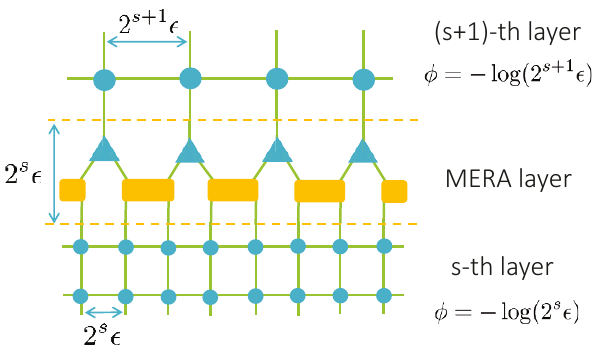
Figure 5 . The tensor network produced when we have a shift of (cid:30) at a speci(cid:12)c layer. This also represents the one step ( s -th) contribution in the process of tensor network renormalization, which (cid:12)nally reaches the MERA network. This corresponds to s (cid:0) th terms R 2